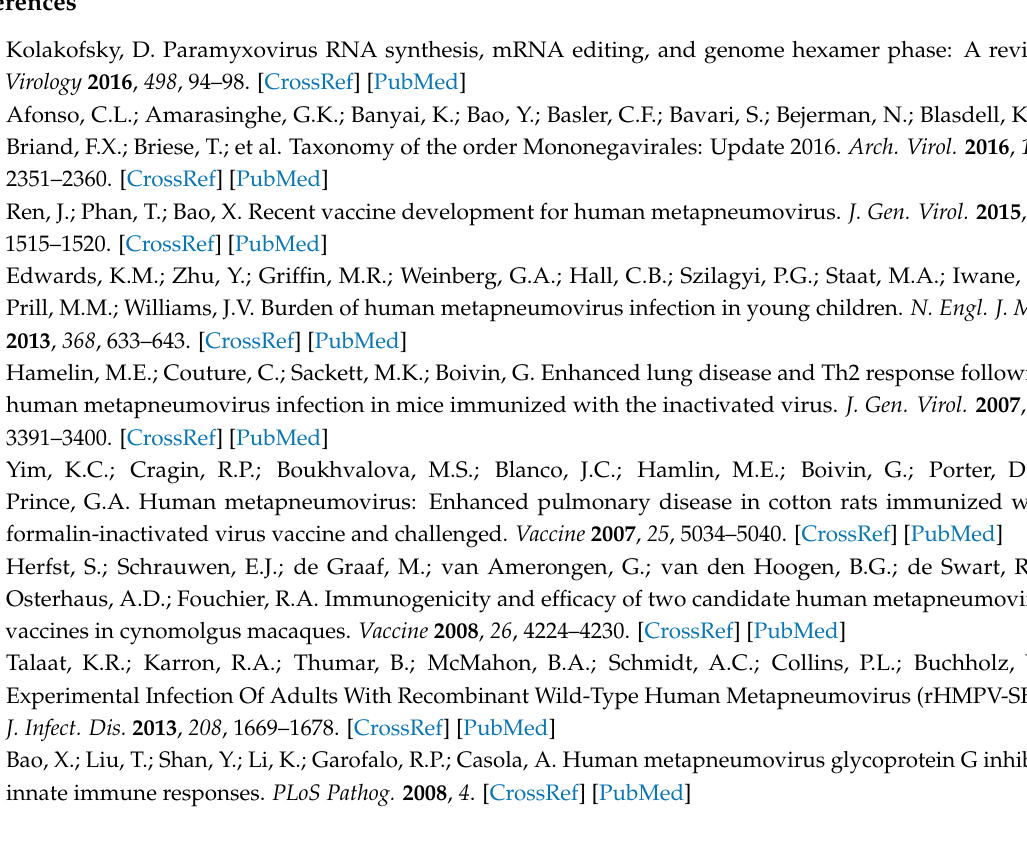
Supplementary Figure S1: The impact of M2-2 motifs on the expression of viral proteins, Supplementary Figure S2: Purity of isolated nuclear compartments, Supplementary Table S1: Nuclear expression of transcription factors, Supplementary Table S2: Nuclear expression of histone proteins, Supplementary Table S3: Motif-regulated biological functions identified by